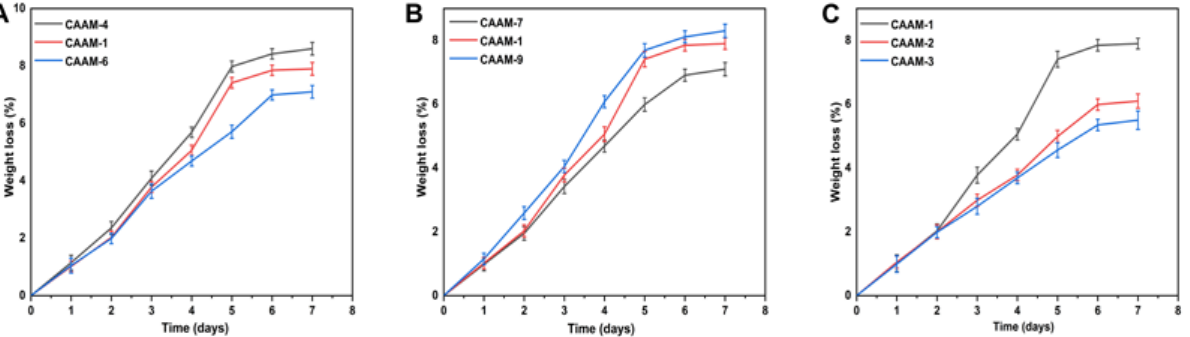
Figure 4. Effect of different weight ratios of hydrogel components on the biodegradation of hydrogels such as AMPS (CAAM-4,1,6) ( A ), CS (CAAM-7,1,9) ( B ), and EGDMA (CAAM-1,2,3) ( C ).